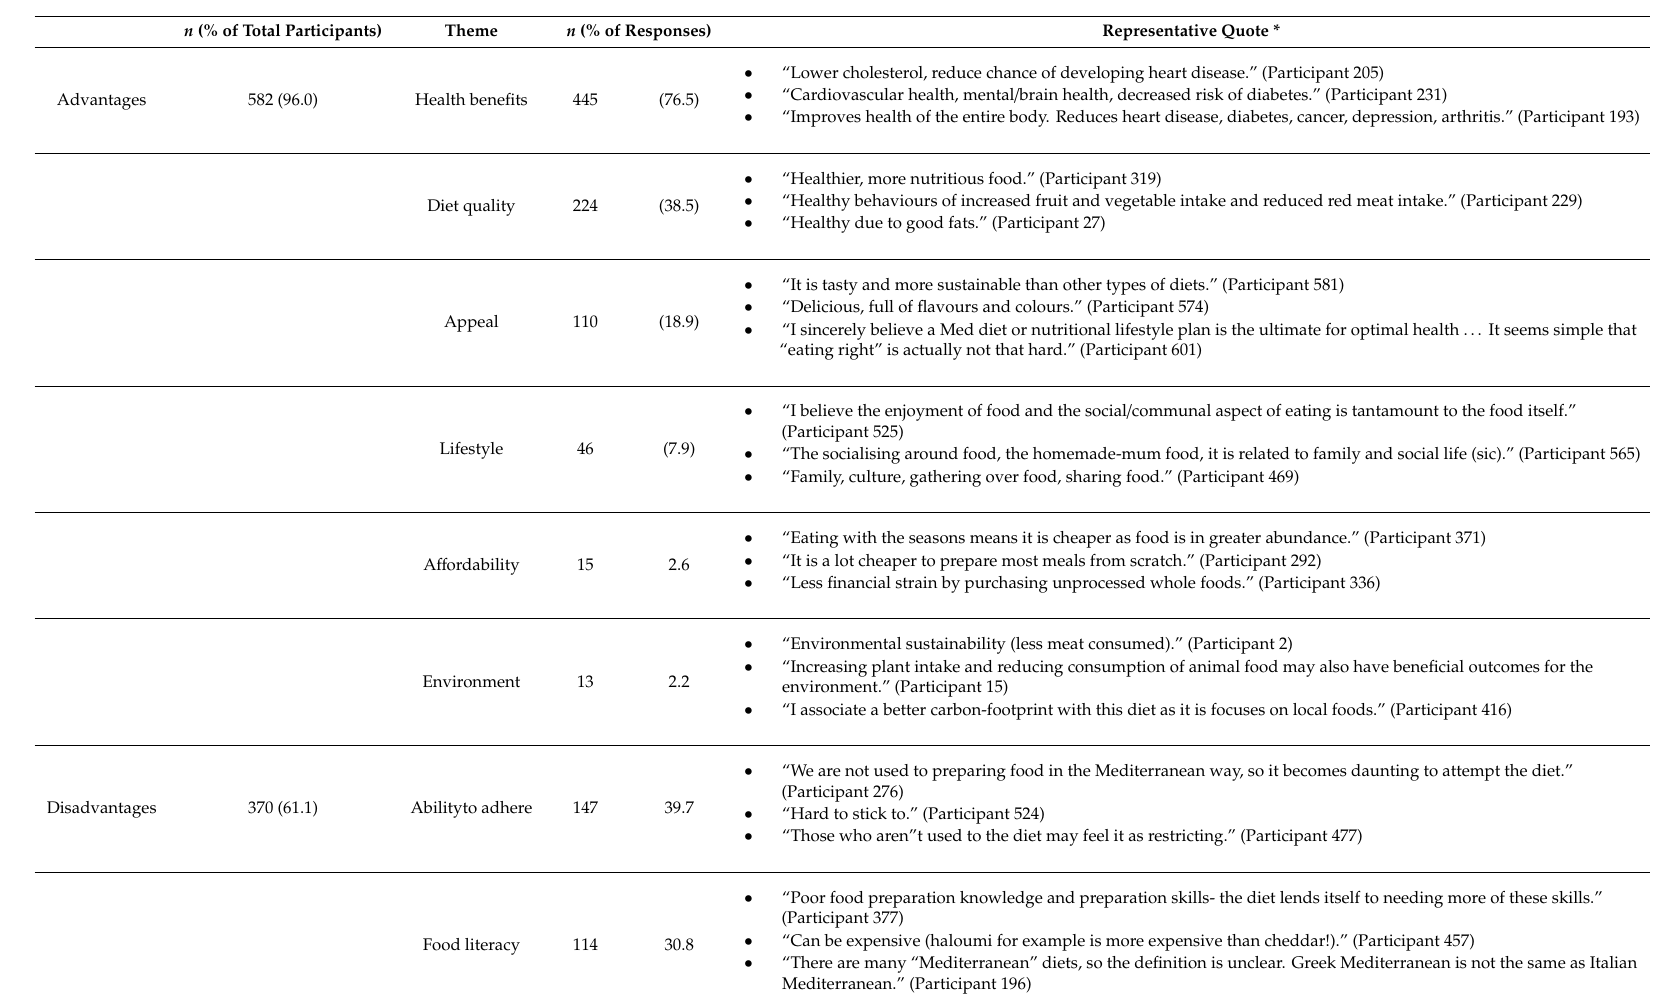
Table 3. Advantages and disadvantages of a Mediterranean diet, reported by Australian